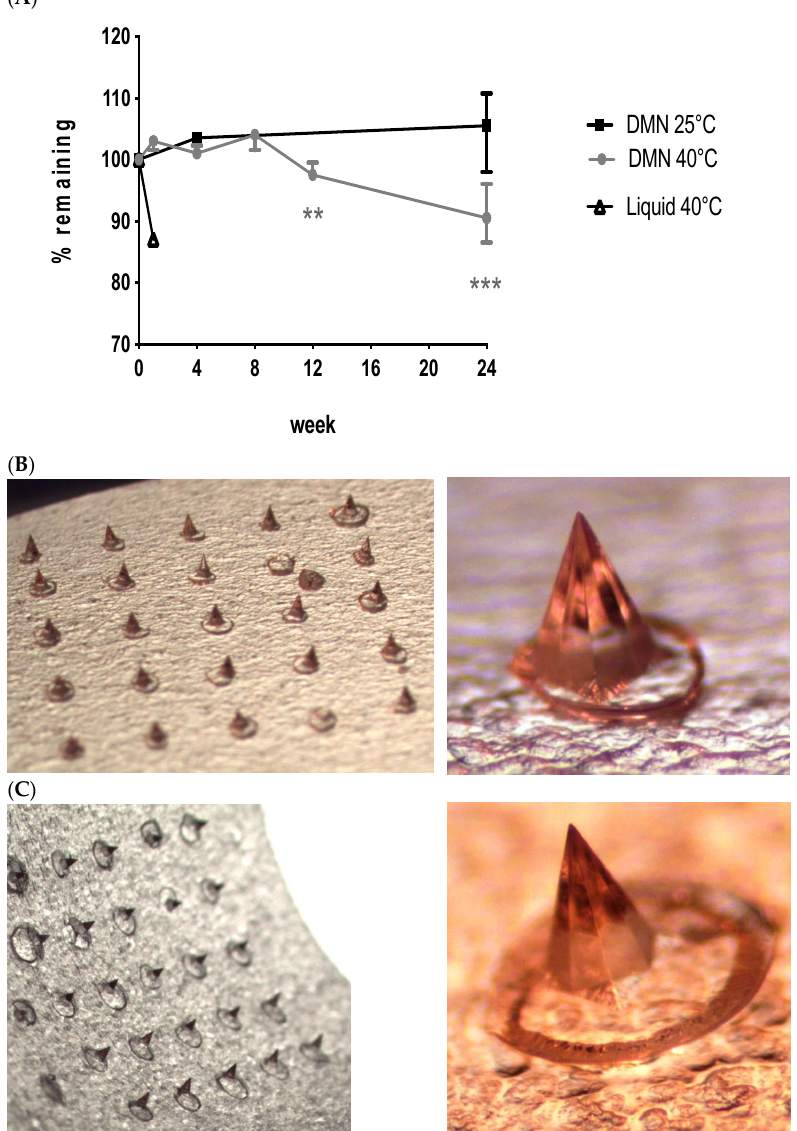
Figure 1. Incorporation of adenovirus vaccine into dissolvable microneedle (DMN) patches signifi- cantly stabilized the vaccine for up to 6 months. AdHu5–PfRH5 containing patches were stored in a stability chamber at 25 °C or 40 °C, with the surrounding chamber maintained at 60% or 75% relative humidity (RH), for the indicated time. ( A ) The initial vaccine dose was 1 × 10 7 ifu per 1 cm 2 patch. The amount of remaining viable adenovirus was measured at 1 week and then 1, 2, 3, and 6 months after incubation of samples (n = 6 per group per timepoint, except at 6 months when n = 4 per group). The % remaining in the sample was determined compared to time zero. No physical changes were observed in DMN stored at accelerated stability conditions. Points represent median, error bars represent inter-quartile range. ** p < 0.01, *** p < 0.001, compared to time zero, Kruskal– Wallis, one-way ANOVA, with Dunn’s multiple comparison test. ( B ) 25 °C, 60% RH, or ( C ) 40 °C, 75% RH, for 6 months.